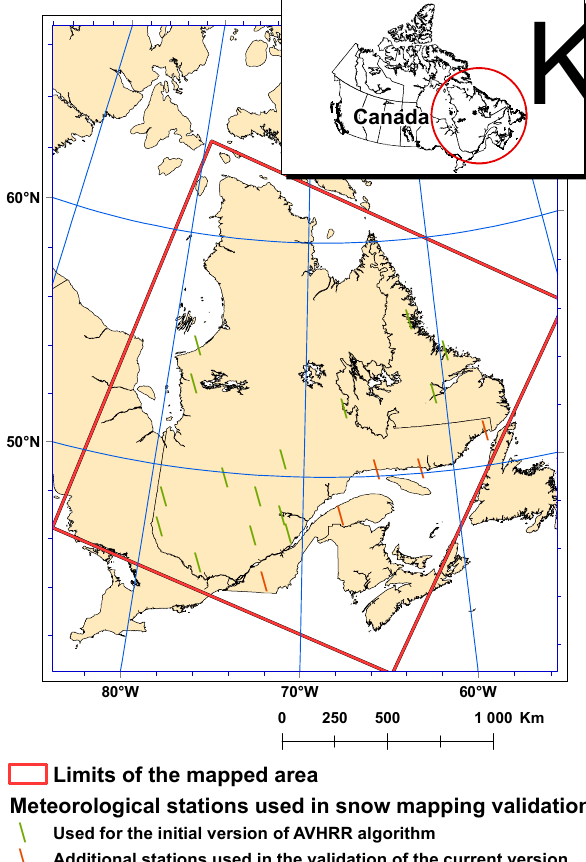
Figure 1. Location of the study area and the meteorological stations used in snow map